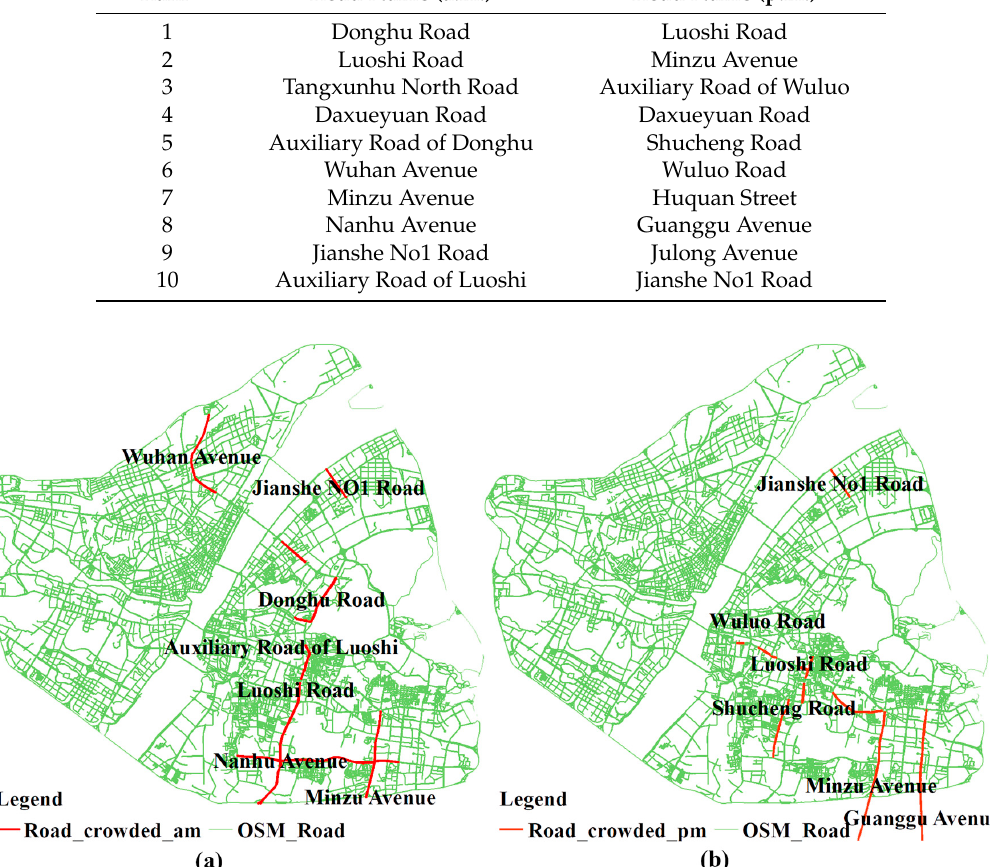
Figure 10. The congestion road sections in rush hour. ( a ) morning peak; ( b ) evening peak.